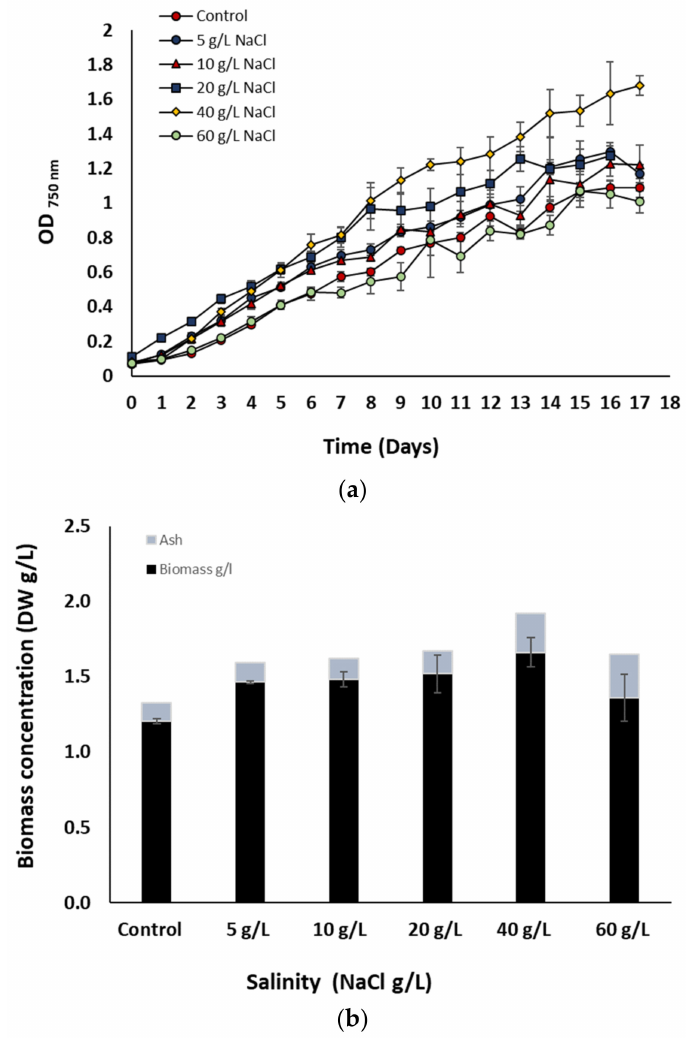
Figure 1. ( a ) Growth kinetics, and ( b ) biomass (dry weight) production of A. platensis cultivated at different salinities. The data represent the mean of n = 3, error bars: standard